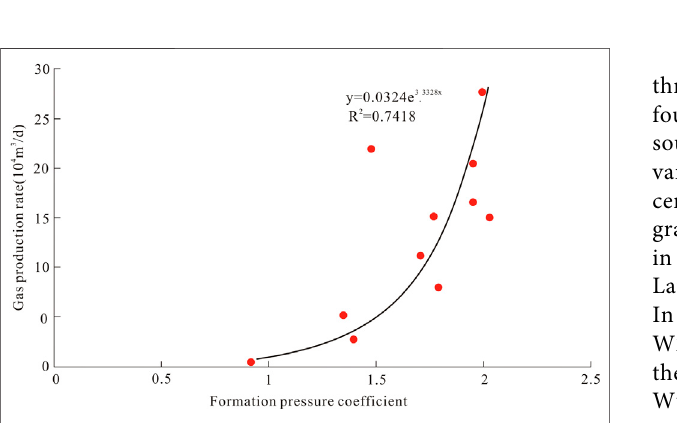
Frontiers in Earth Science |